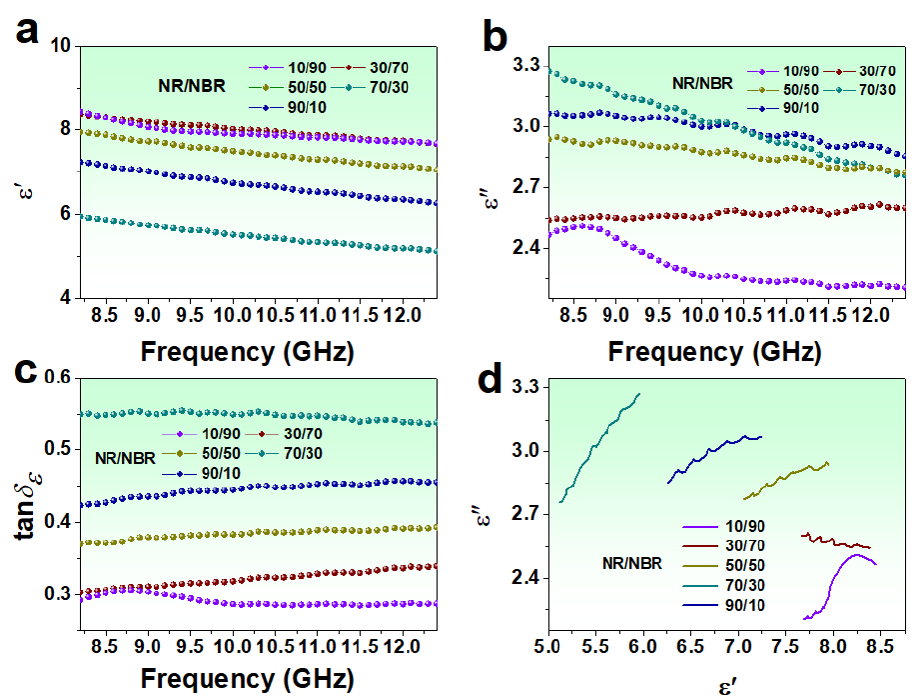
Figure 4. The real ε′ ( a ) and imaginary ε” ( b ) parts of the complex permittivity, and the dielectric loss tangent factor tan δε ( c ); Cole-Cole curves ( d ) of 6 phr PPyNT filled NR/NBR composites with different ratios of NR/NBR.